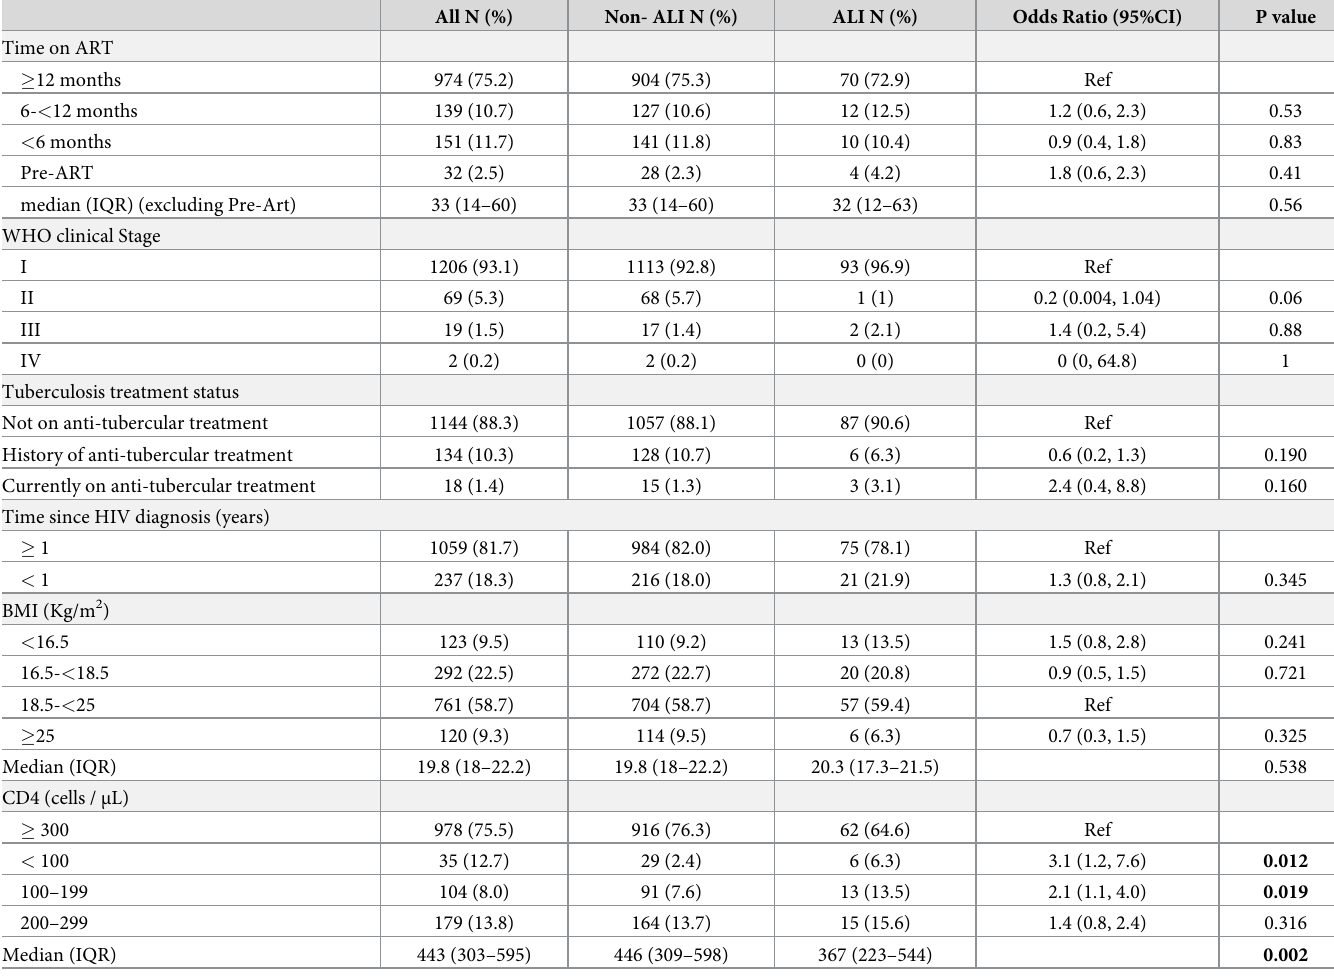
Table 4. HIV-related risk factors for asymptomatic Leishmania infection (ALI) in 1,296 people living with HIV (PLHIV) in Bihar,